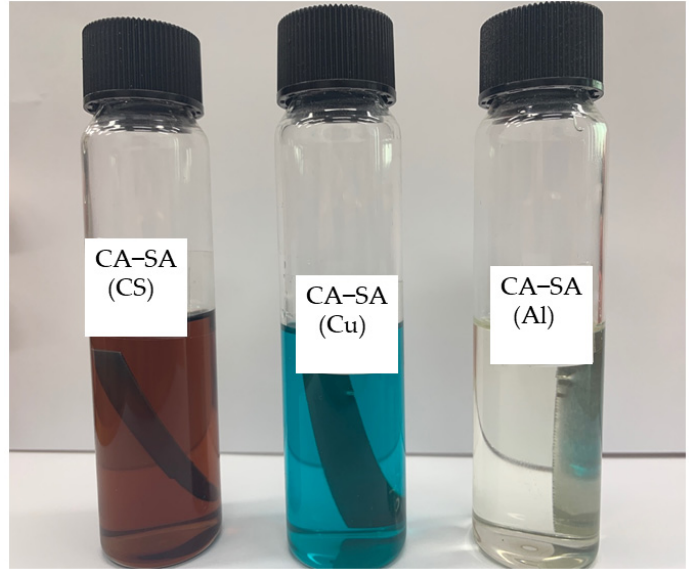
Figure 11. Metal samples in eutectic PCM after 12 weeks.